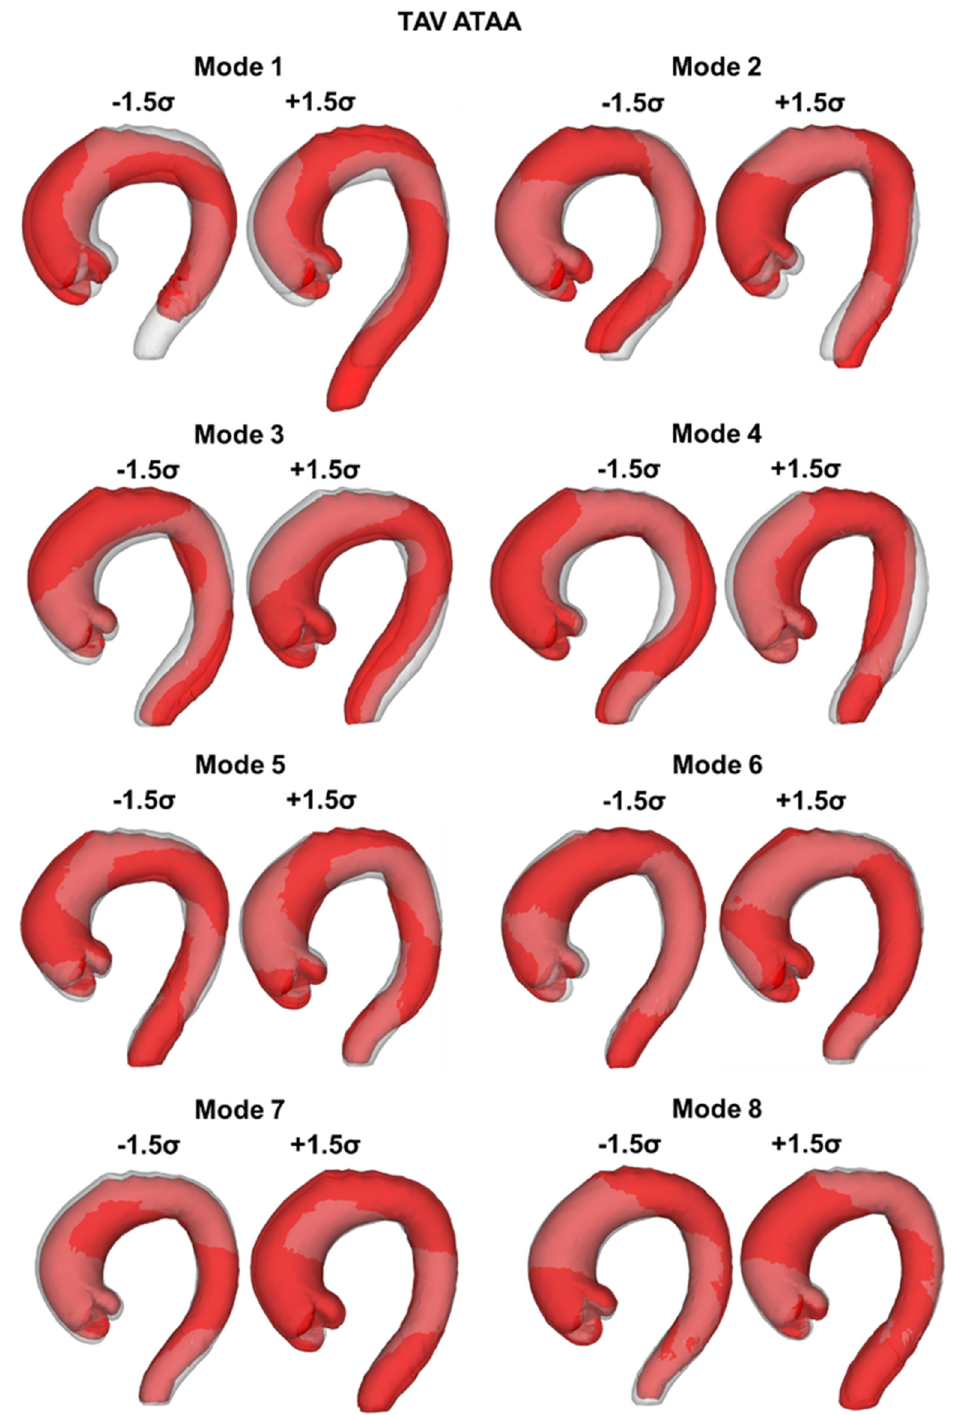
Figure 3. Dominant shape modes shown by deforming the mean TAV ATAA template (grey color) from low ( − 1.5 σ ) to high (+1.5 σ ) shape boundaries (red color).